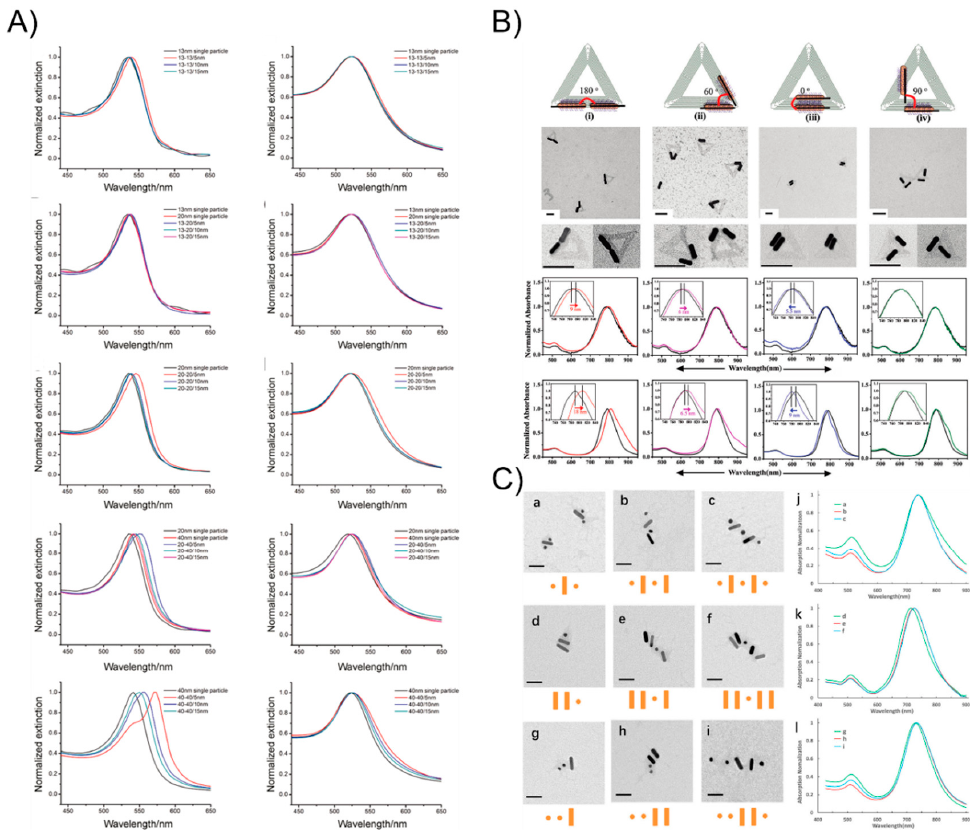
Figure 4. The plasmonic extinction of the DNA-assisted self-assemblage of AuNP nanostructures. ( A ) DNA linker-based symmetric and asymmetric AuNP dimer structures show an expected red-shift with increasing particle sizes or reducing interparticle distances. ( B ) DNA origami-guided AuNR dimers exhibit a red-shift of the LSPR peak for constructs 180° and 60°, respectively, and a blue shift for construct 0° and almost no shift for construct 90°. ( C ) DNA origami clamps-guided heterogeneous plasmonic nanostructures show that closely arranged AuNRs with longitudinal resonance peak with red-shifts, but this is not observed when they were separated by small spherical AuNPs. Reproduced